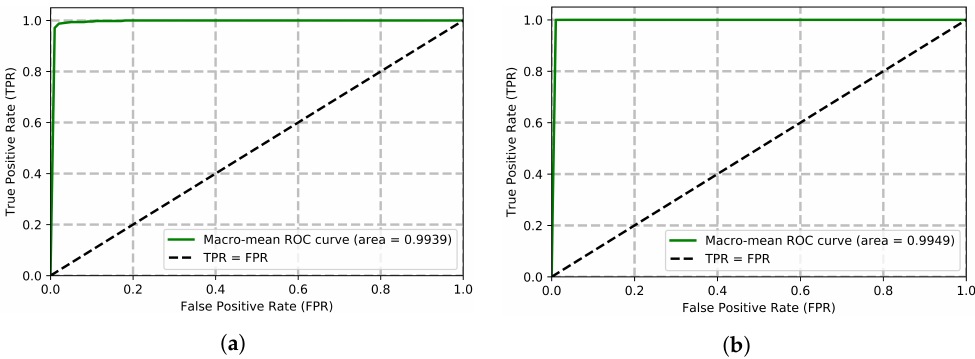
Figure 7. ROC curves on the UPCV and KGB datasets. ( a ) On UPCV dataset. ( b ) On KGB dataset.